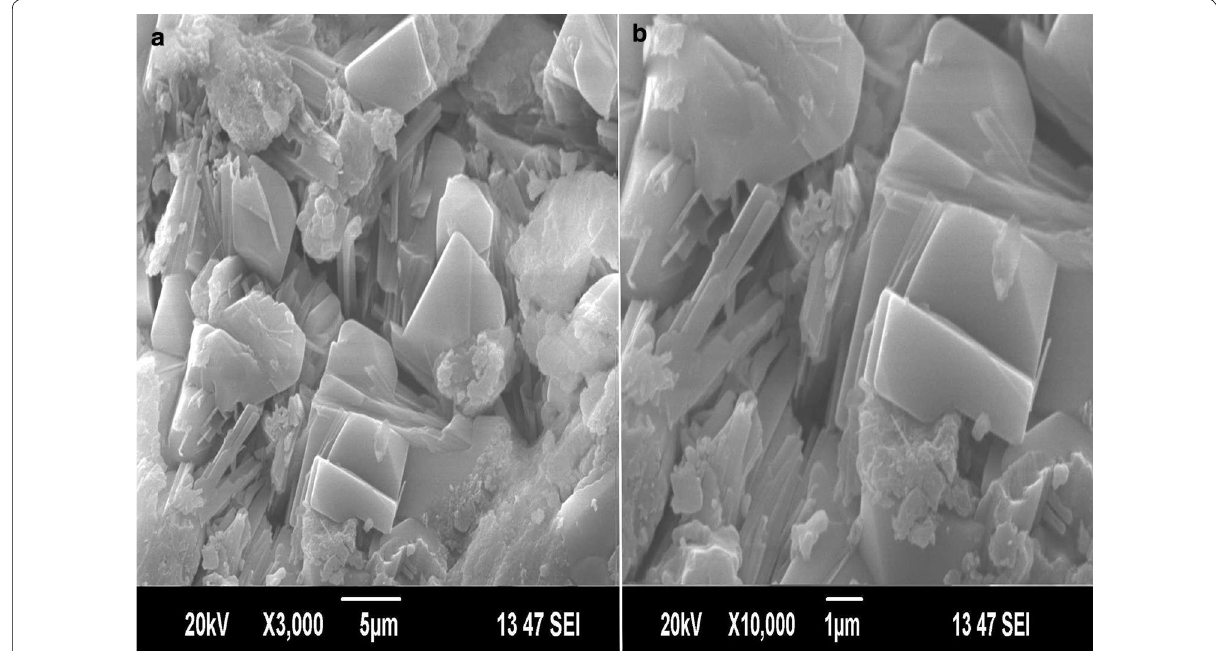
Fig. 6 SEM micrograph of AMNP. a The magnification scale of 5 μm shows the cubic crystals, b the magnification scale of 1μm shows the size of the crystals that are in nanometric scale